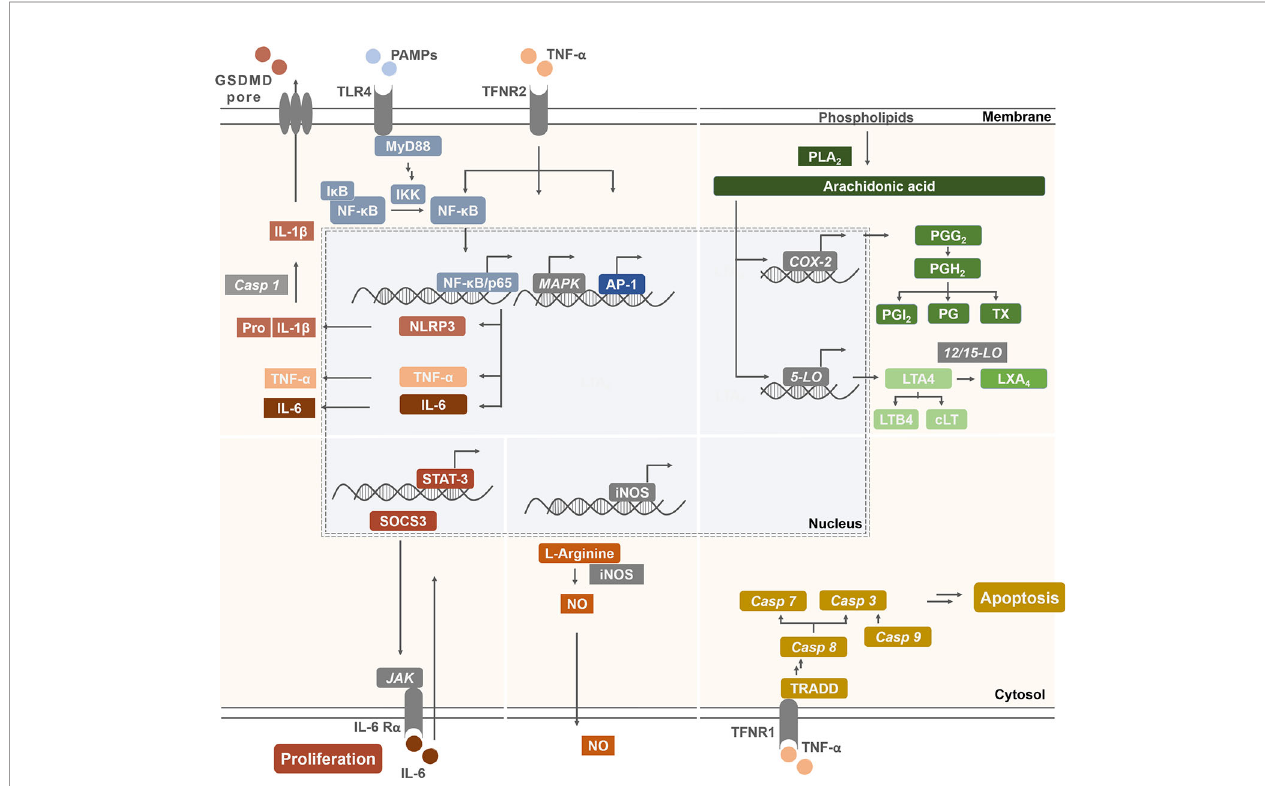
FIGURE 7 | Schematic illustration of signaling targets, pathways, and molecules involved in in fl ammatory response and cancer progression. Pathways were chosen due to known interactions with the compounds of interest. In fl ammatory signaling molecules are interleukins (IL), tumor necrosis factor- a (TNF- a ), nitric oxide (NO), prostaglandins (PG), prostacyclin (PGI 2 ), tromboxanes (TX), leukotriens (LT), and lipoxins (LX). Their expression, synthesis, or release depends, among others, on the activation of NF- k B, NLR family pyrin domain containing 3 (NLRP3) in fl ammasome, inducible nitric oxide synthase (iNOS), cyclooxygenase (COX)-2, and lipoxygenases (LO). In addition, membrane receptors, such as cytokine or epidermal growth factor receptors regulate the activation of nuclear receptor signal transducer and activator of transcription (STAT) 3 as well as extrinsic or intrinsic pathways which trigger the activation of caspases (Casp). These mediators are therefore important factors for modulating the balance between cell proliferation and apoptosis, which is essential to prevent carcinogenesis.